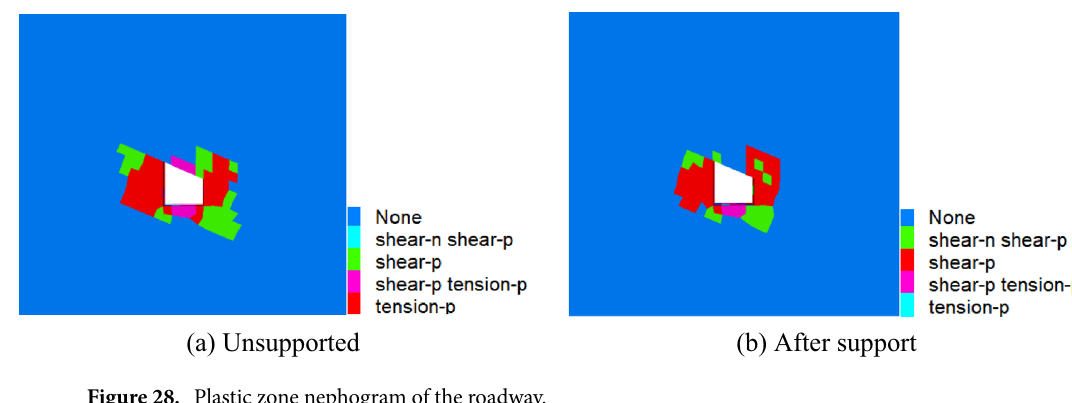
Figure 28. Plastic zone nephogram of the